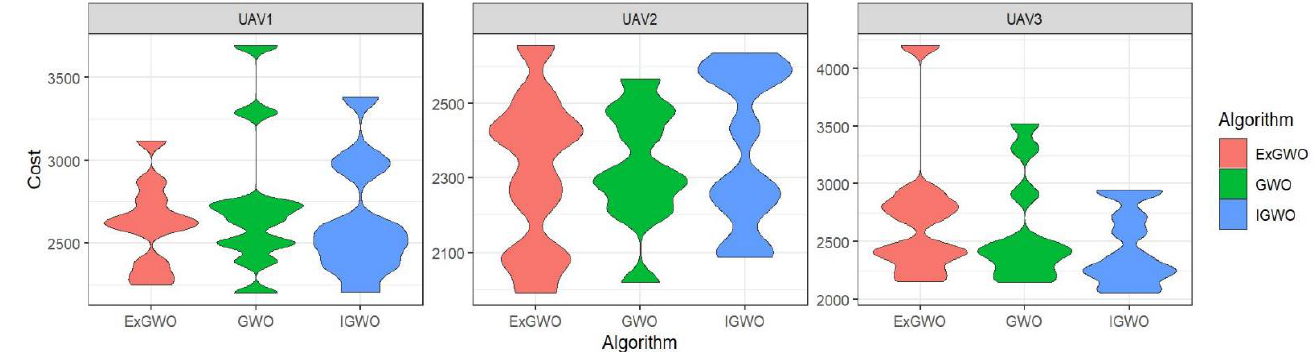
Figure 11. Distributions of costs in 15 runs for each UAV in population of 30 and 50 iterations.